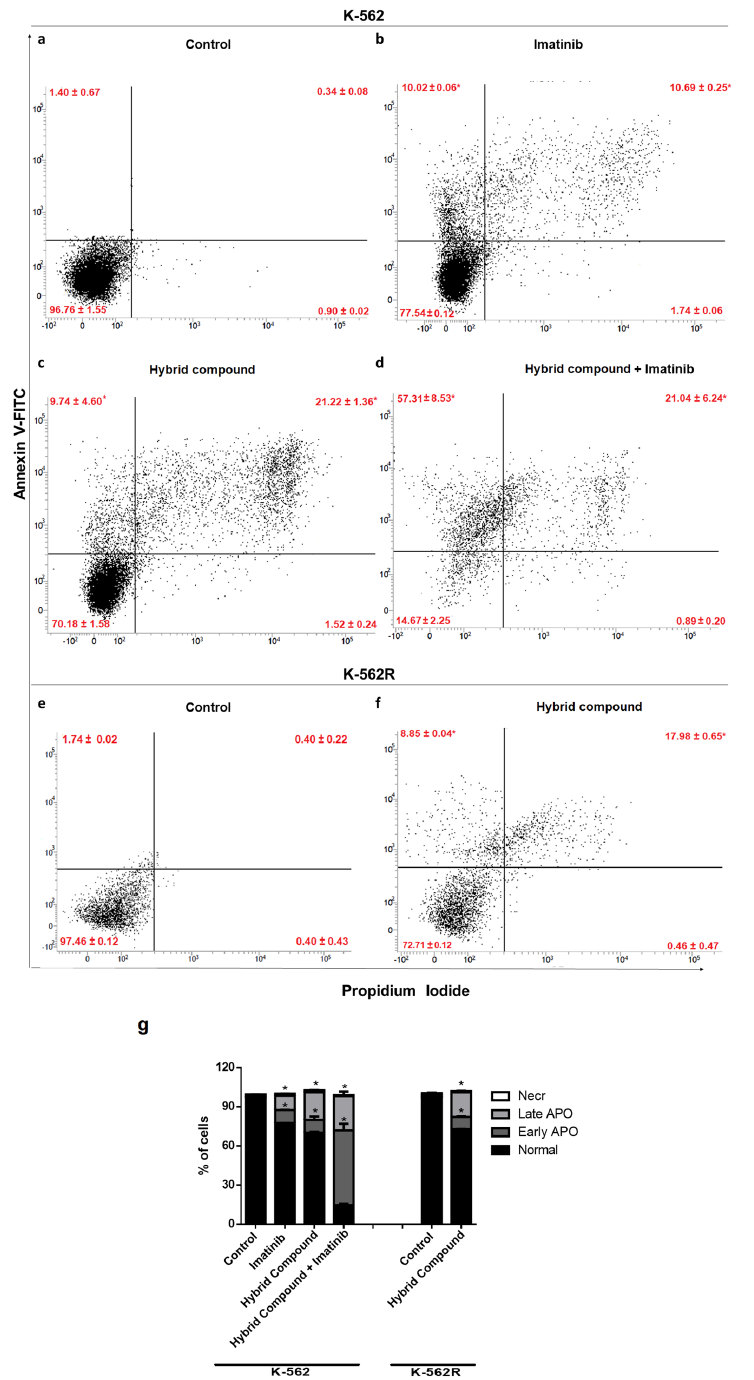
Figure 3. Representative analysis of apoptosis by flow cytometry after 48 h of treatment of K-562 cells with ( a ) only RPMI-1640 medium, ( b ) imatinib, ( c ) hybrid compound and ( d ) a combination of hybrid compound and imatinib, and of K-562R cells with ( e ) only RPMI 1640 medium or ( f ) hybrid compound. ( g ) Right, average values measured in each gate: NORMAL cells, annexin V − /IP − ; NECR cells annexin, V − /IP+; EARLY APO cells, annexin V+/IP − ; LATE APO cells and annexin V+/IP+. Data are reported as mean ± standard deviation (SD) of three experiments (* p < 0.05; relative to untreated control